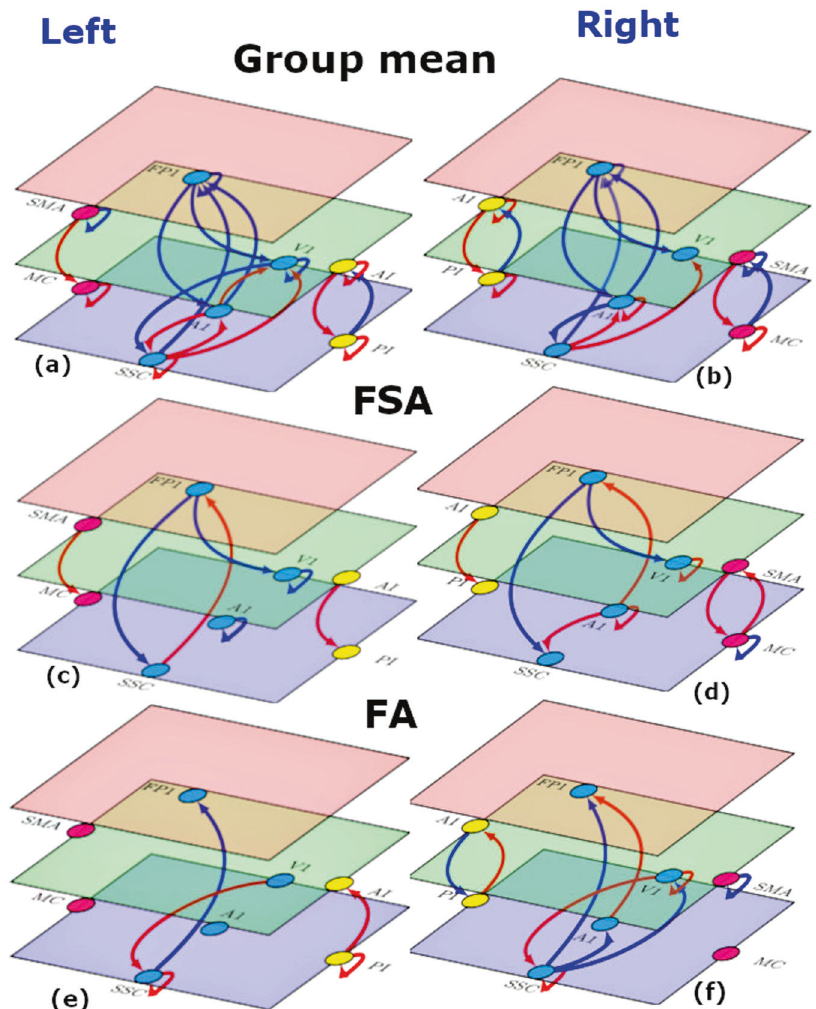
Fig. 5 Effective connectivity (left and right hemispheres). a , b Group mean effective connectivity in sensory and motor networks. Arrow colors code nature of connections red, excitatory; blue, inhibitory. c – f Connections showing signi fi cant association with FSA c , d and FA e , f scores in sensory and motor networks. Arrow colors code direction of connectivity changes relative to the group mean: red, increased; blue, decreased. For all sub fi gures, line thickness is kept constant and does not code for the effect size. For the exact values of the estimated connectivity parameters see Appendix A. Nodes are placed in different planes to denote relative position of different nodes in cortical hierarchy. SMA: supplementary motor area, MC: primary motor cortex, FP1: lateral frontal pole, V1: primary visual cortex, A1: primary auditory cortex, SSC: primary somatosensory cortex, AI: anterior insula, PI: posterior which are resolved by (inhibitory) top-down predictions. Con- versely, in motor hierarchies, prediction errors are generated by (excitatory) top-down proprioceptive predictions, which are resolved by motor re fl exes at the level of the spinal-cord. In line with the marked consistency of the patterns of top-down effective connectivity, the changes in backward effective con- nectivity — with the extent of somatic arousal — also showed a consistent pattern and fi t comfortably with phenomenology of anxiety syndromes. With increasing somatic anxiety scores, the patterns found in top-down connections at the group level are accentuated in all three networks. In other words, connections from lateral frontal pole to primary exteroceptive cortices become more inhibitory, whereas connections from supplementary motor area to primary motor cortex — and from anterior to posterior insula become more excitatory with increasing somatic anxiety. Enhancement of top-down processing in exteroceptive networks is in line with the hypervigilance and heightened sensitivity to external stimuli in anxiety and increased Sensory Processing Sensitivity (SPS) [16, 17] in several anxiety disorders. The